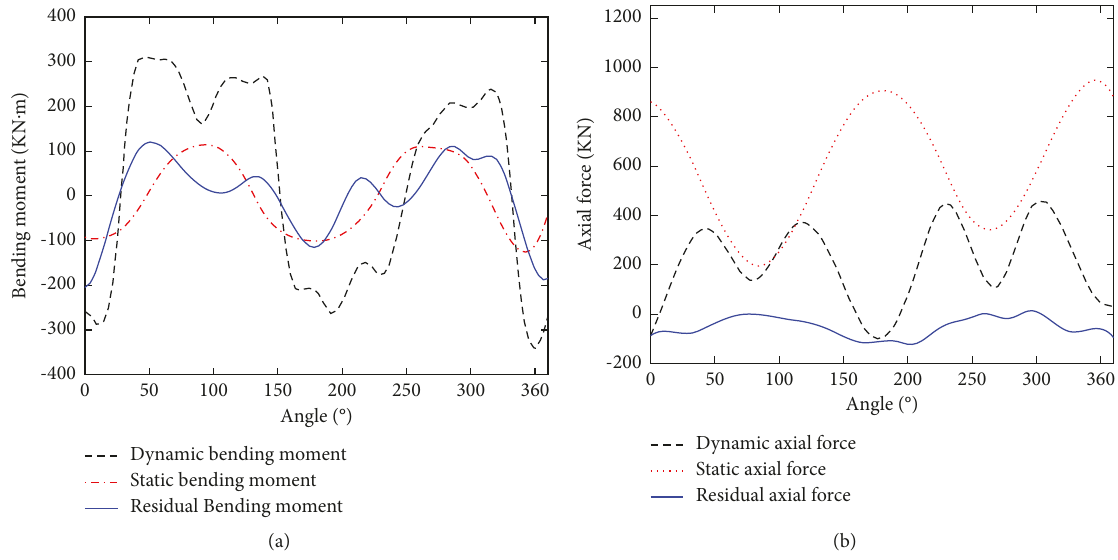
Figure 3: (a) Distribution of bending moment at each position of lining under seismic force. (b) Distribution of axial force at each position of lining under seismic